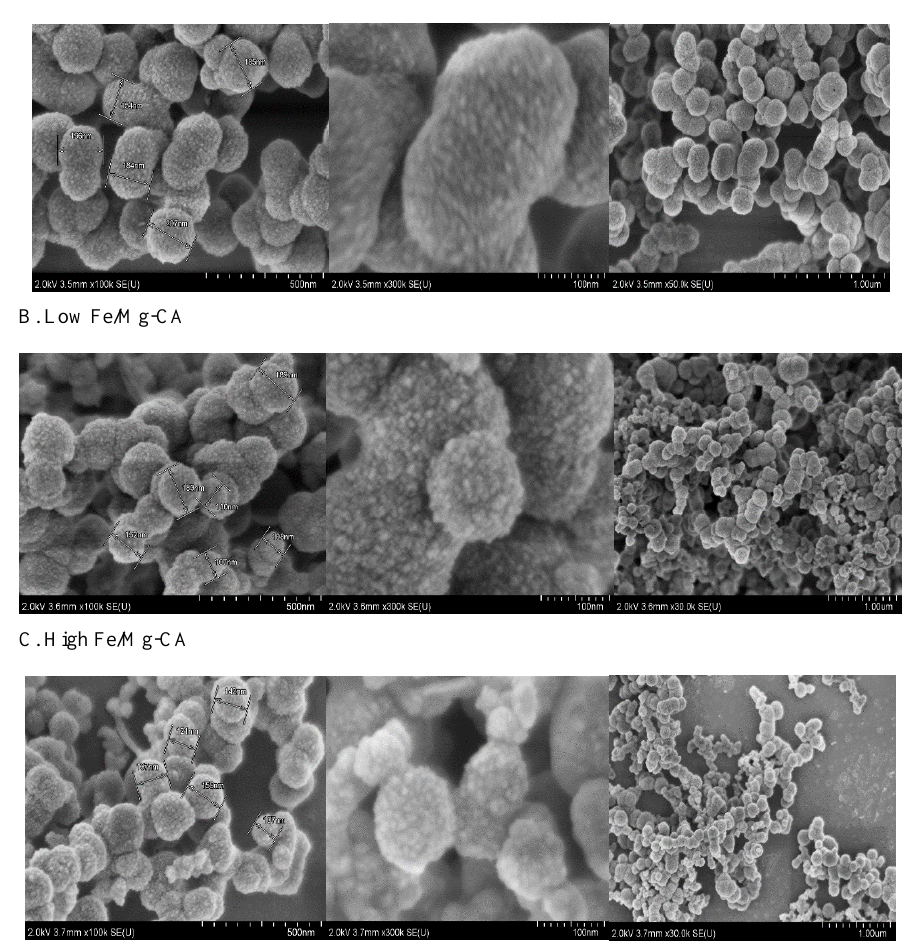
Figure 6. Field emission scanning electron microscopy (FESEM) micrographs in absence of 10% FBS showing size, shape and surface morphology of differently formulated particles. Scale bar: 500 nm, 100 nm, and 1 µm. ( A ) CA ( B ) Low Fe/Mg-CA ( C ) High Fe/Mg-CA. After the respective particles were incubated at 37 °C for 30 min, they were centrifuged twice for 15 min at 13,000 rpm. The supernatants were discarded and the pellets were resuspended in 20 µL Milli Q water. Then 3 µL of the respective NP suspensions was dried at room temperature for 45 min.